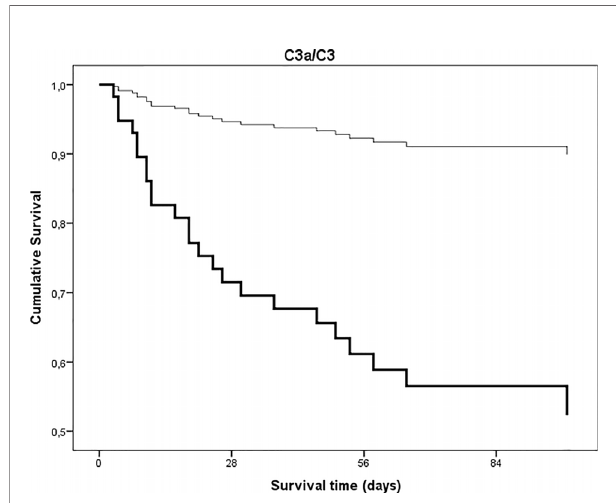
FIGURE 7 | Univariate time to in-hospital, all-cause mortality Cox proportional-hazards regression analysis in patients with COVID-19 as strati fi ed by level of anaphylatoxin C3a. Patients were strati fi ed according to C3a levels (cut point 324 ng/mL p = 0.002).